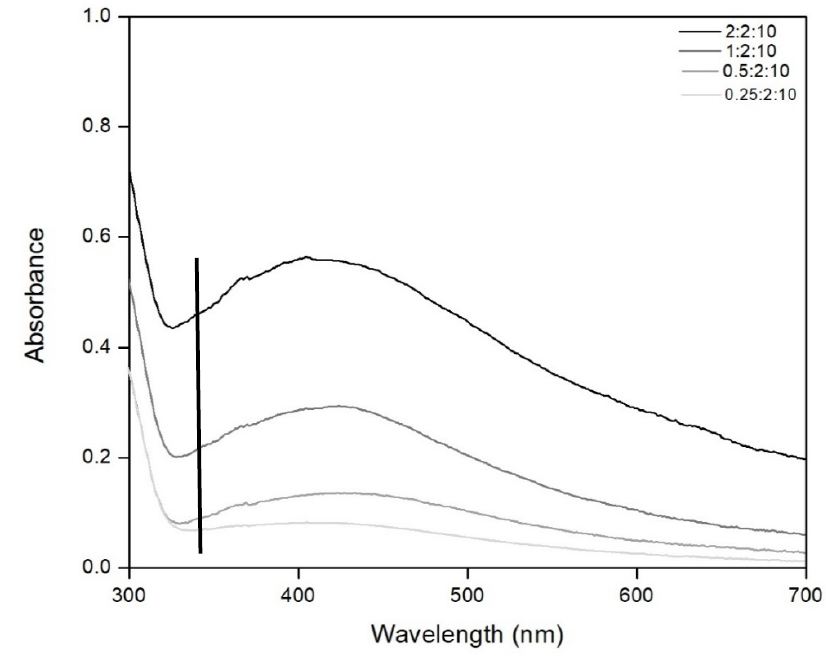
Figure 2. UV–VIS absorption spectra for di ff erent precursor:reducing agent: water ratios.